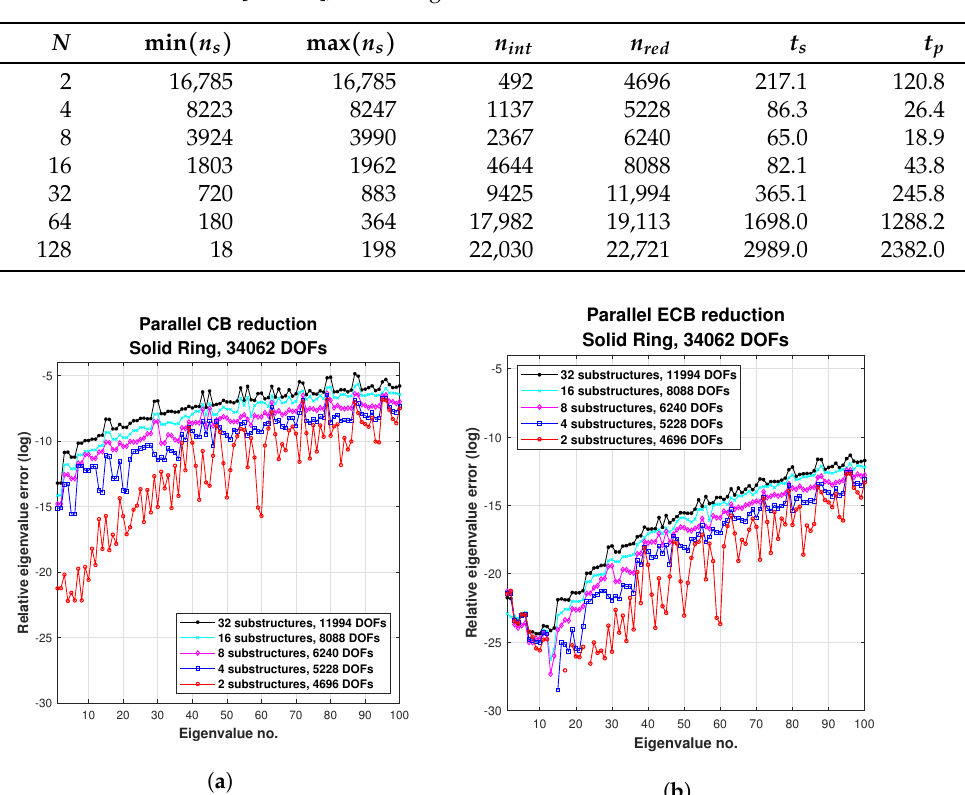
Figure 5. Comparison of reduced model accuracy, solid ring. The results are obtained by ( a ) the CB method and ( b ) the ECB method,